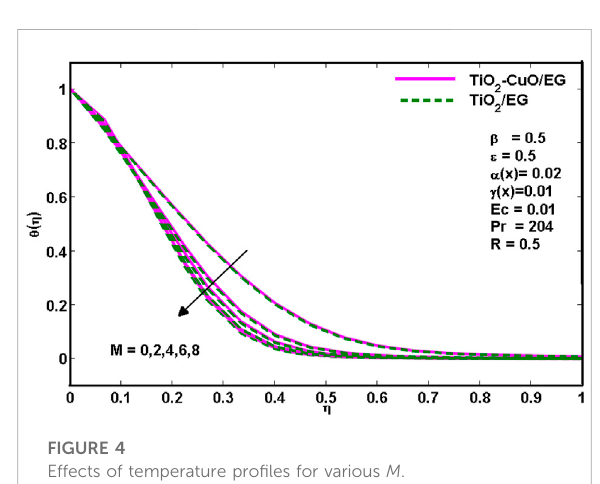
FIGURE 4 Effects of temperature pro fi les for various M